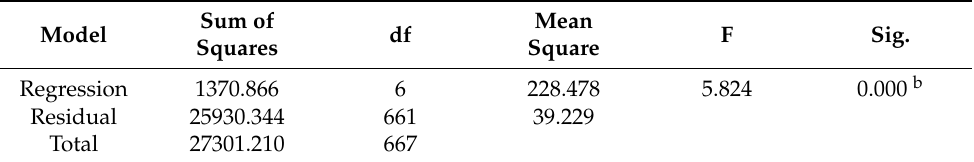
Table 4. Predictors for burden of prevention using ANOVA a